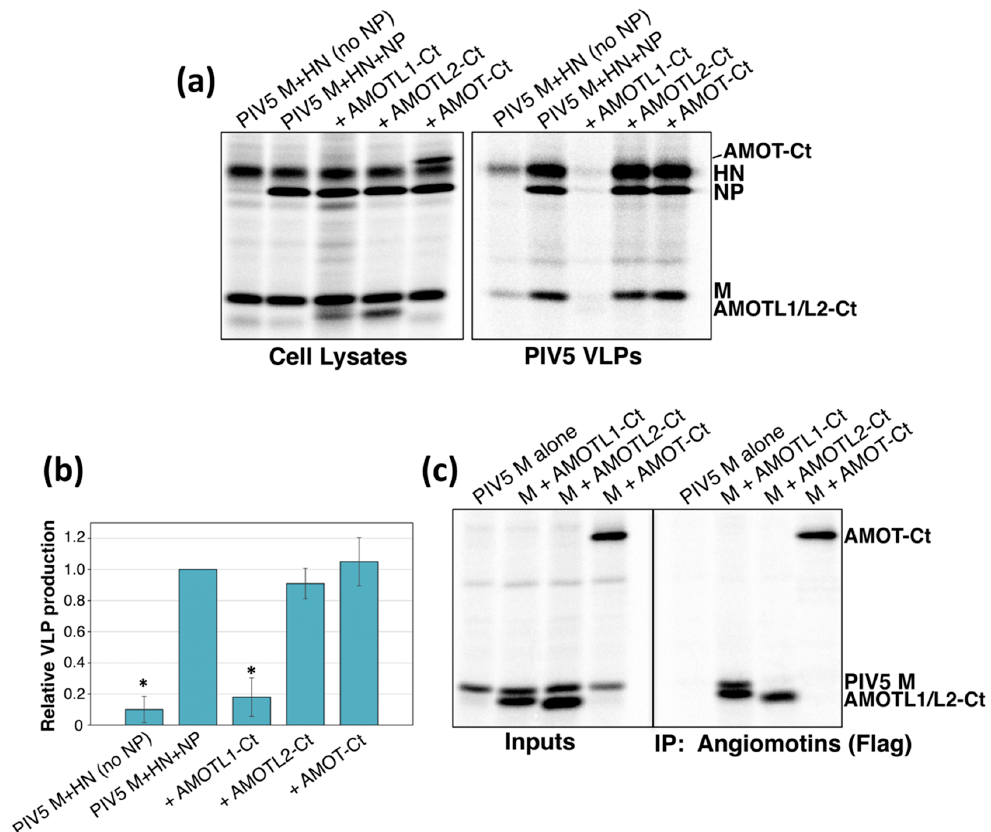
Figure 3. M-binding, AMOTL1-derived polypeptides inhibit the budding of PIV5 VLPs, but the corresponding AMOT- and AMOTL2-derived polypeptides do not. ( a ) 293T cells were transfected to produce PIV5 M, HN, and NP proteins together with the indicated angiomotin-derived polypeptides. After metabolic labeling of cells, lysates were prepared and viral proteins and angiomotin-derived polypeptides were immunoprecipitated. VLPs from culture supernatants were purified by centrifugation through sucrose cushions followed by flotation on sucrose gradients. Purified VLPs were loaded directly onto SDS gels without immunoprecipitation, and proteins were visualized using a phosphorimager. ( b ) Four independent experiments were performed as described for panel ( a ), and VLP production efficiencies were calculated as the amount of viral M protein detected in VLPs divided by the amount of M protein detected in the corresponding cell lysate fraction and were normalized to the values obtained in the absence of any polypeptide co-expression. Error bars indicate standard deviations. Differences from the values obtained in the absence of polypeptide co-expression were assessed for statistical significance by using a two-tailed Student’s t -test, and p values less than 0.01 are denoted by an asterisk. ( c ) 293T cells were transfected to produce PIV5 M protein together with the indicated Flag-tagged angiomotin-derived polypeptides, and co-immunoprecipitation was evaluated as described in the legend to Figure 1.